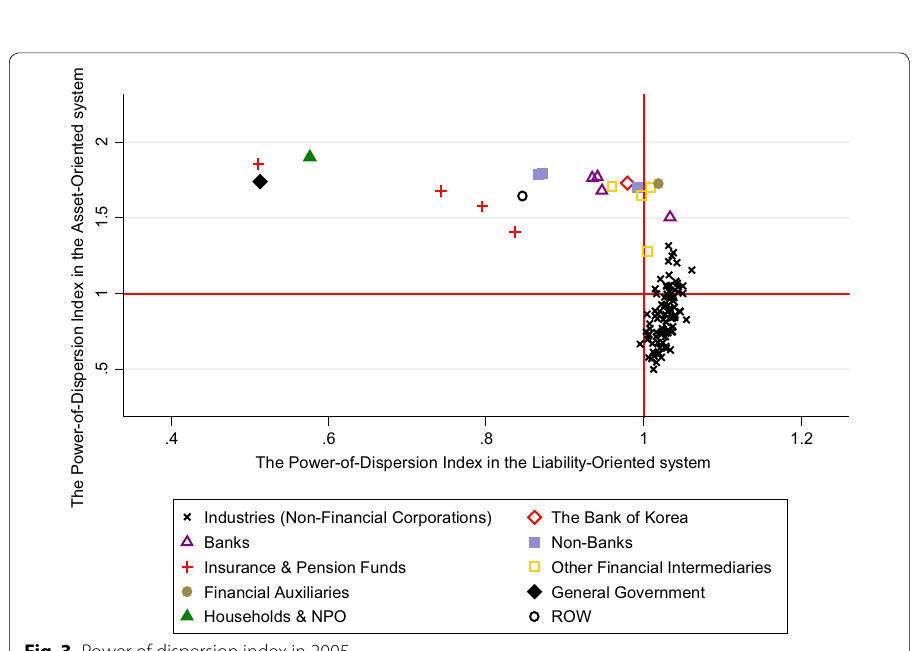
Fig. 3 Power of dispersion index in